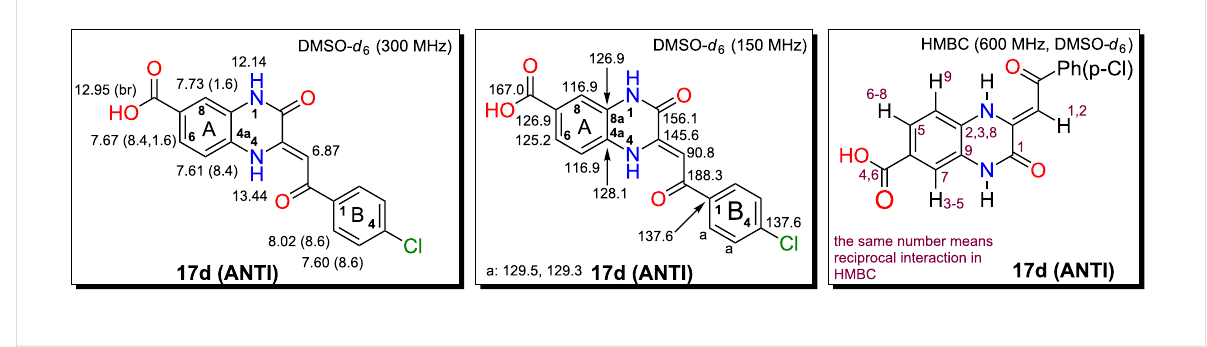
Figure 4: NMR assignments for compound 17d